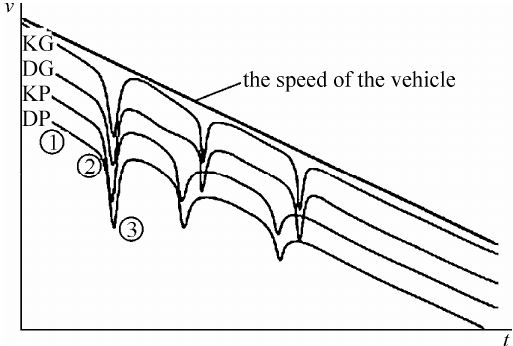
Fig 1. Diagram of variation of the speed of a vehicle with ABS on its braking